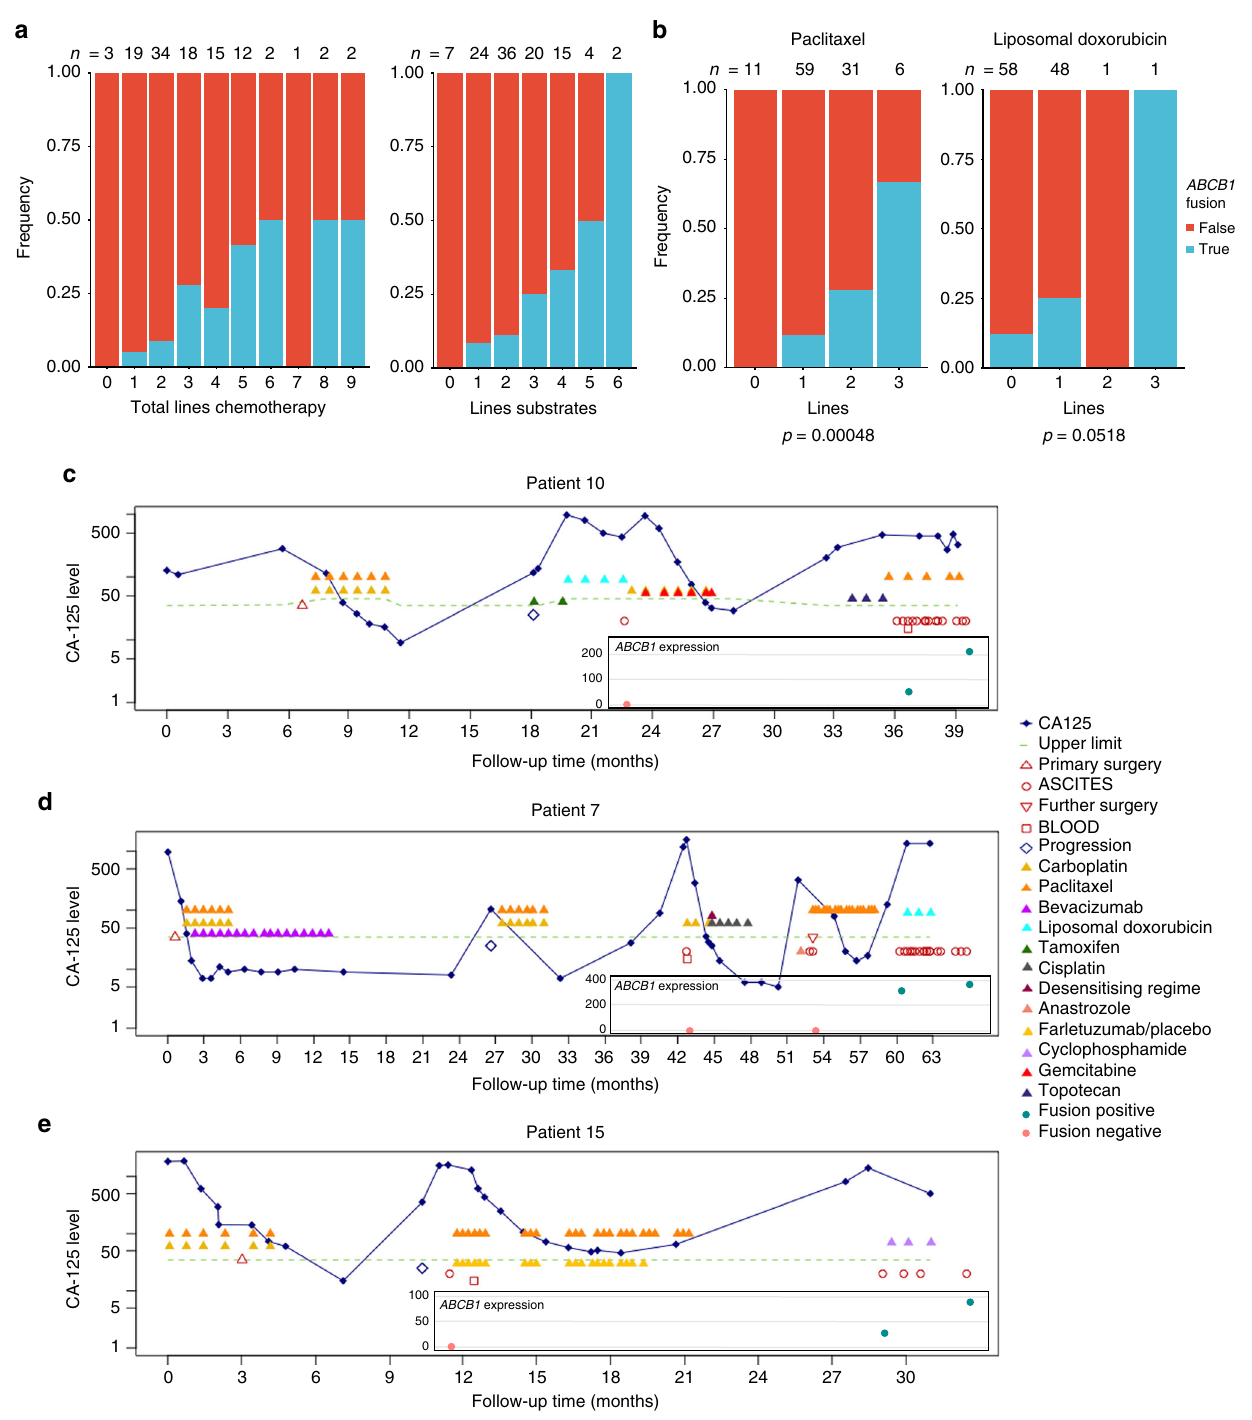
Fig. 3 Association between treatment and fusion status. a Associations were identi fi ed between the total number of chemotherapy lines and number of MDR1 substrate chemotherapy lines and fusion positivity. b The number of lines of paclitaxel were signi fi cantly associated with fusion positivity, the number of lines of liposomal doxorubicin was not signi fi cant (Wilcoxon test). c – e CA125 serum marker pro fi le for Patients 10, 15 and 7 where multiple recurrent ascites samples were tested for ABCB1 expression (by Q-RT-PCR) and fusions, as indicated in graph